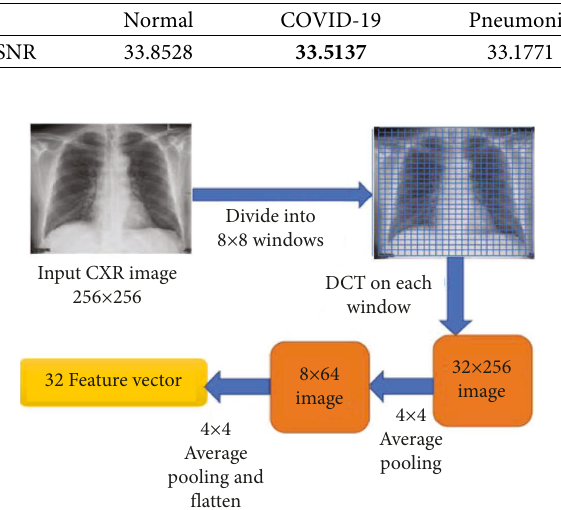
Figure 2: Feature extraction steps for the 3-set classification.